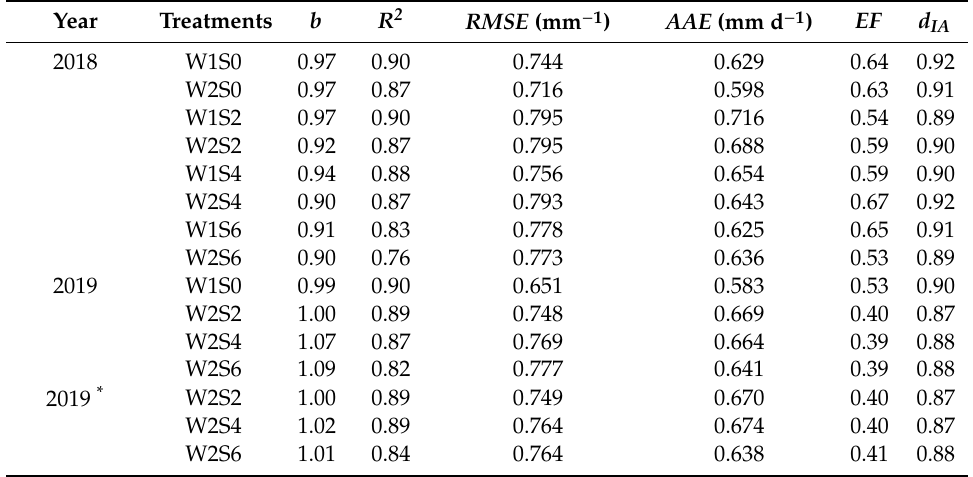
Table 3. Indicators of goodness of fit of soil evaporation ( E ) related to the SIMDualKc model validation for